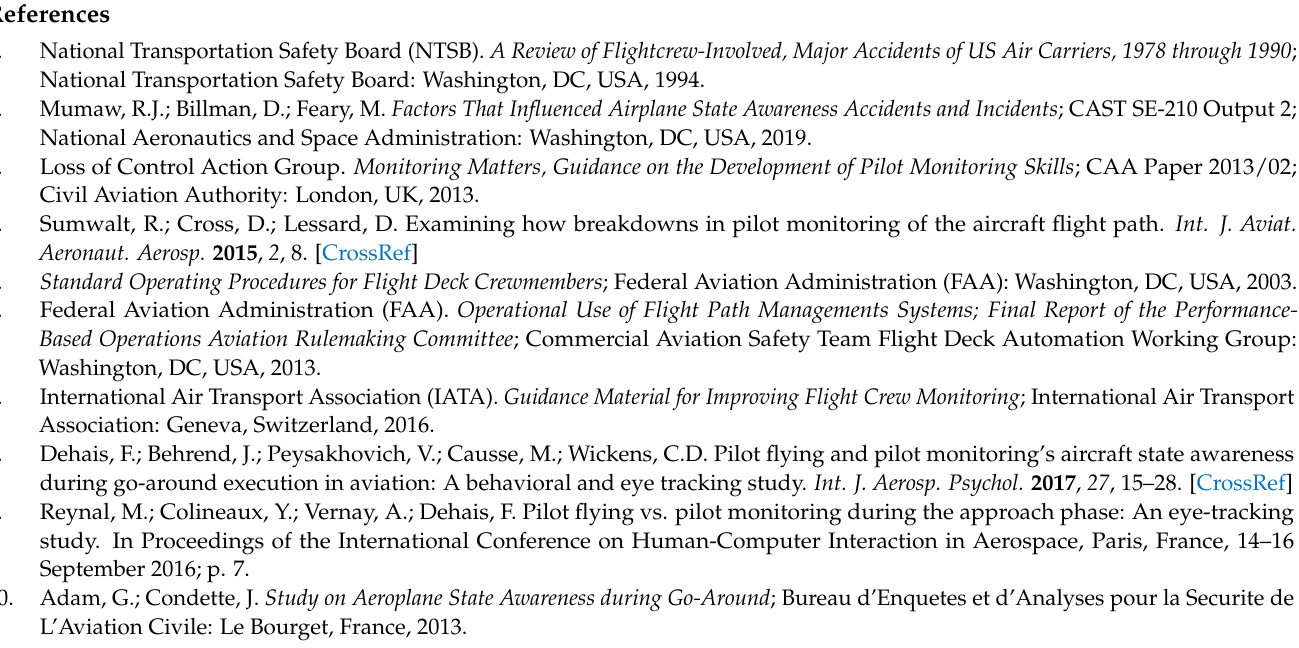
Table S9: Percentage of the four efficient visual scanning patterns and other patterns for the experi- mental group during the post-training